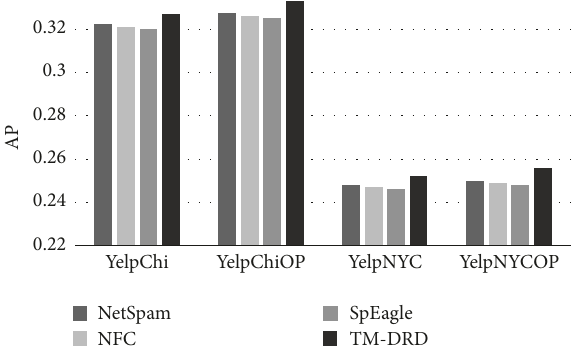
Figure 8: The AP for TM-DRD and SpEagle, NFC, and NetSpam in different